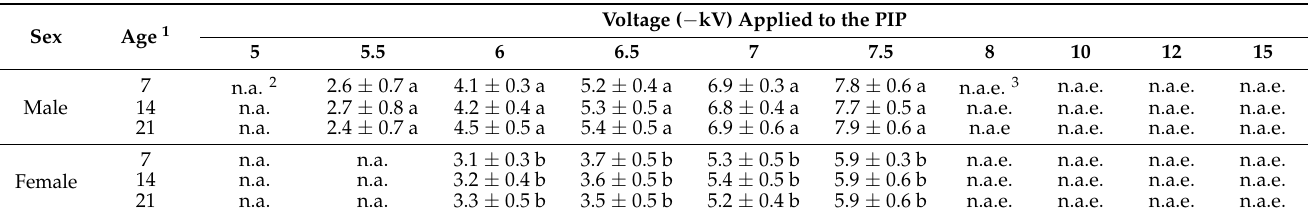
Table 2. Time (s) required for male and female adult houseflies captured with the negatively charged PIP of the EFP at different voltages to escape from the